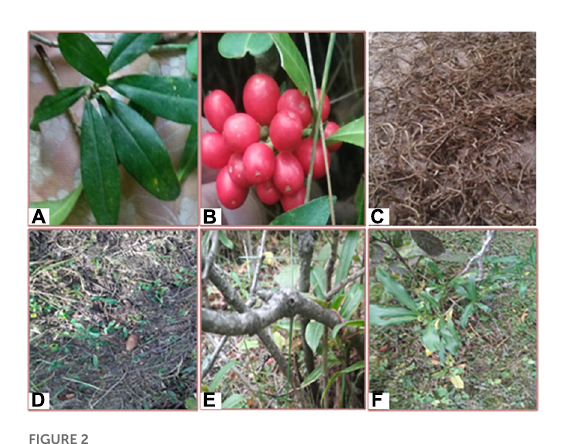
FIGURE2 (A) Leaves of Skimmia anquetilia , (B) Berry of S. anquetilia , (C) Dried root of S. anquetilia , (D) Plant in nature, (E) Stem of S. anquetilia , (F) Whole plant of S. anquetilia